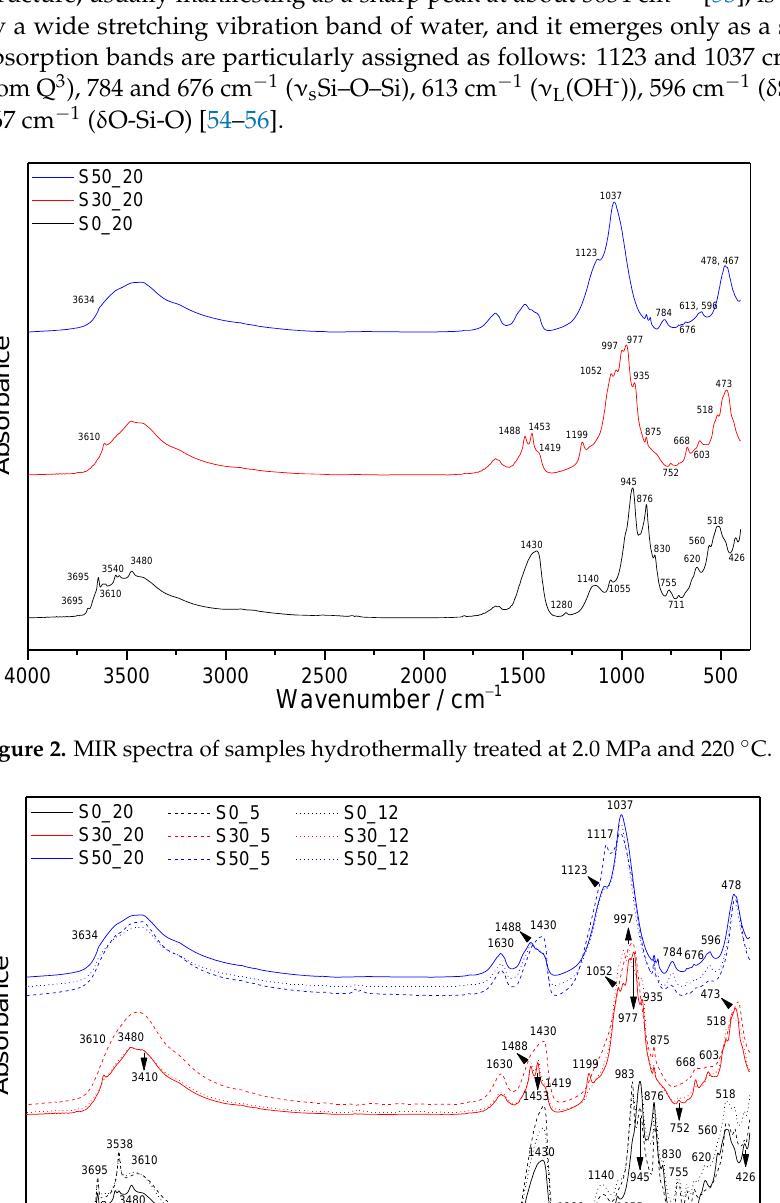
Figure 4. Segment of infrared spectra of all hydrated samples and referential dry cement between 1250 and 750 cm −1 . 3.2. XRD As a result of the complexity of the studied systems, the analysis of the MIR spectra would be very difficult or nearly impossible without performed XRD. XRD patterns of the samples corresponding to boundary compositions and applied conditions (220 °C, 2.0 MPa) are shown in Figure 5. Irrespectively of the composition, unreacted clinker phases, C 3 S and C 2 S, are still present in the samples. The initially formed ettringite (Ca 6 Al 2 (SO 4 ) 3 (OH) 12 · 26H 2 O, C 6 A S̅ 3 H 32 ), confirmed in the 24 h samples, decomposed to form anhydrite. Unlike the FTIR analyses, which indicated the presence of various car- bonates, only calcite is confirmed by XRD. Pozzolanic reactions of SF resulted in the con- sumption of portlandite, which was evidenced only in the sample without its addition (S0_20). In addition, the formation of α-C 2 SH and jaffeite was prevented by SF, and these phases were determined only in the sample without it (S0_20). Whilst pure cement paste